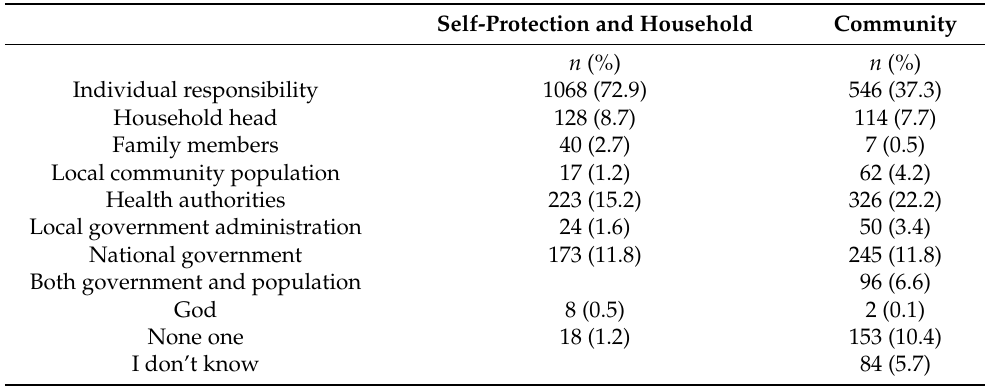
Table 8. Awareness about responsibility in the control and prevention of mosquitoes and mosquito- borne diseases.